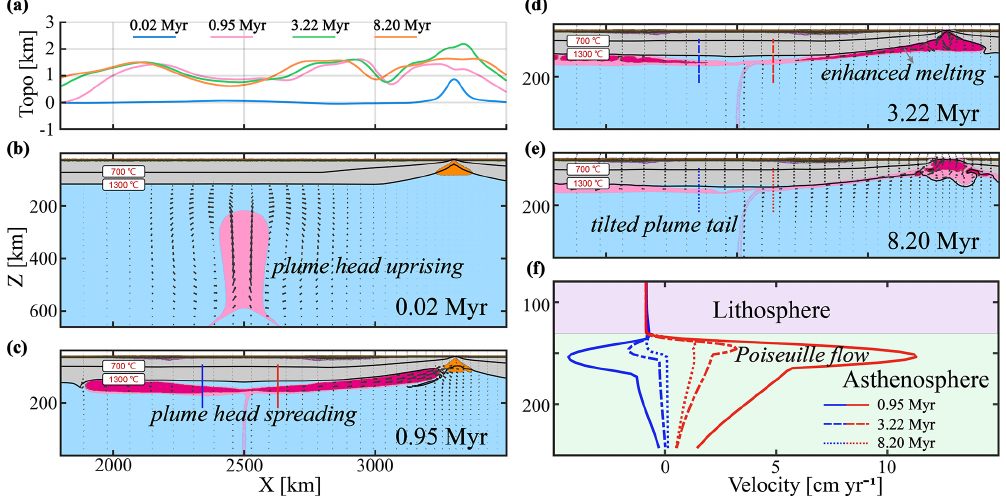
Figure 3. The evolution of the reference model M12 (see Table S1 in Supplement) with dominant ridgeward plume flow. The main model parameters employed in this case are as follows: half-spreading rate of 8mmyr − 1 , an initial plume head radius of 200km and an off-axis distance of 800km. (a) Surface topography over time along the flow path. (b–e) Snapshots of composition for the reference model (M12). (f) Profiles of the horizontal velocity component over time at the sections, as indicated (color-coded) in panel (c–e)